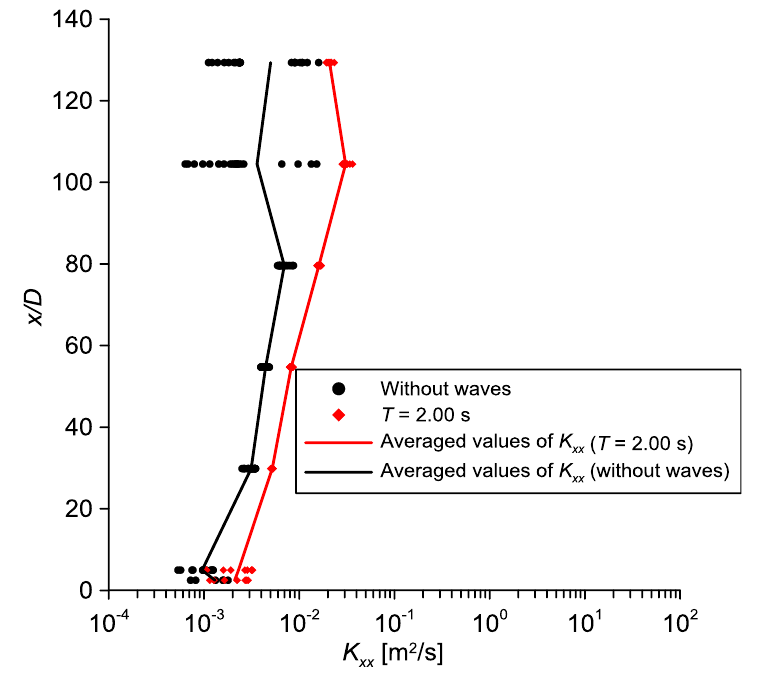
Figure 14. Values of K xx of Run 1 of Table 1 and of the same jet without waves with lines of the averaged values of each cross section.